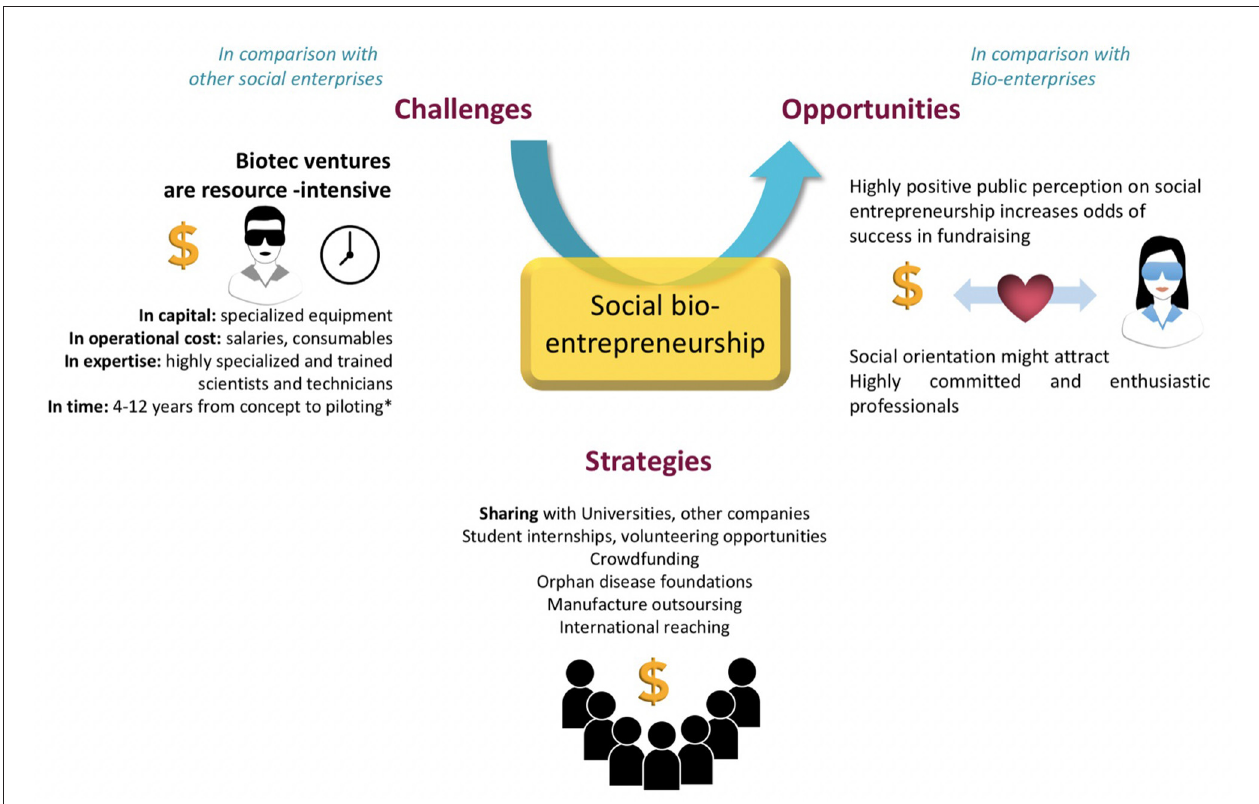
FIGURE 5 | Challenges, strategies, and opportunities of social bioentrepreneurship as compared to social and